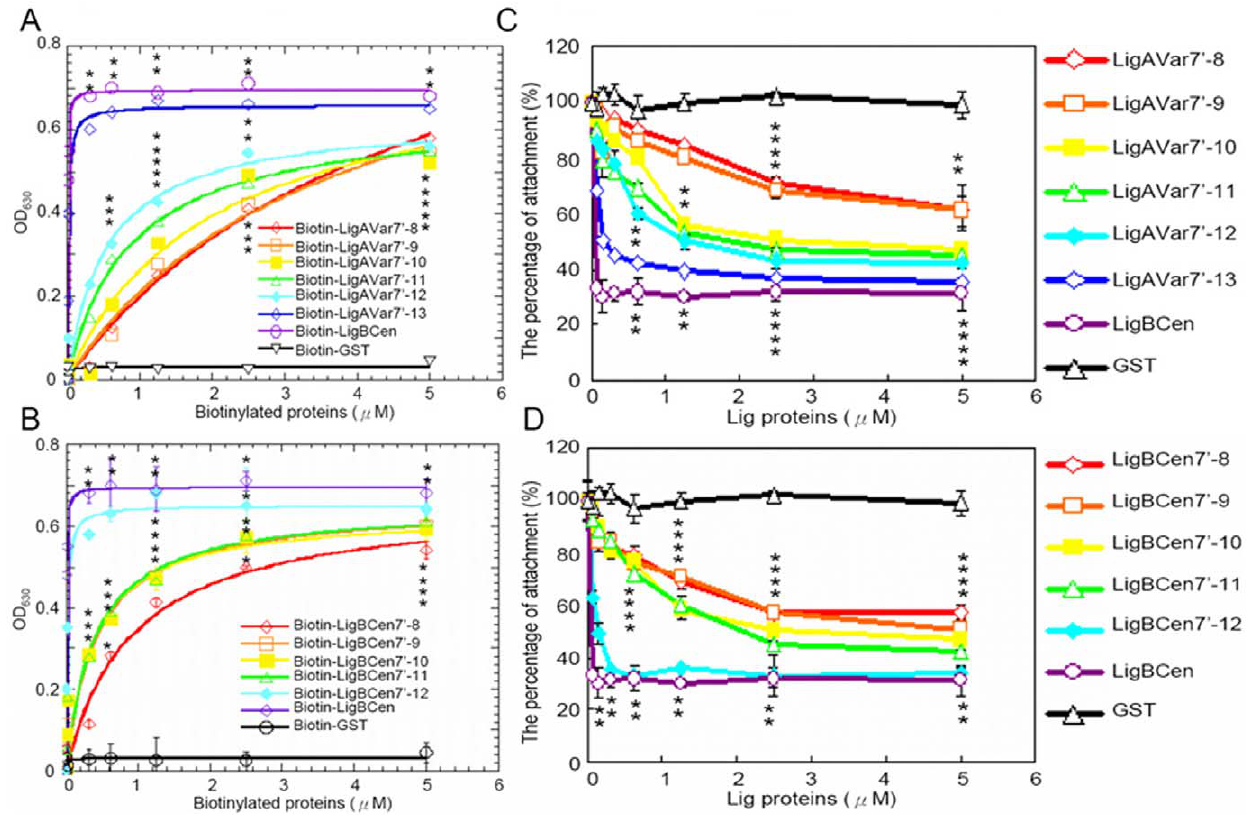
Figure 4. Terminal Ig-like domains mainly mediates Lig protein binding and Leptospiral adhesion on MDCK cells. (A and B) Binding of truncated Lig proteins to MDCK cells. Various concentrations (0.08, 0.16, 0.3125, 0.625, 1.25, 2.5, 5 m M) of biotinylated LigCon (negative control), LigBCen (positive control), and (A) LigAVar7’-13, LigAVar7’-12, LigAVar7’-11, LigAVar7’-10, LigAVar7’-9, LigAVar7’-8, (B) LigBCen7’-12, LigBCen7’-11, LigBCen7’-10, LigBCen7’-9, LigBCen7’-8 were added to MDCK cells (105), and binding was measured by ELISA. (C and D) Truncated Lig proteins inhibit the binding of Leptospira to MDCK cells. MDCK cells were incubated with various concentrations (0.08, 0.16, 0.3125, 0.625, 1.25, 2.5, 5 m M) of biotinylated -LigB1706-1716, or biotin (negative control) (C) LigAVar7’-13, LigAVar7’-12, LigAVar7’-11, LigAVar7’- 10, LigAVar7’-9, LigAVar7’-8, (D) LigBCen7’-12, LigBCen7’-11, LigBCen7’-10, LigBCen7’-9, LigBCen7’-8 prior to the addition of Leptospira (107). The adhesion of Leptospira to MDCK cells (105) was detected by ELISA. The reduced percentage of attachment was determined relative to the attachment of Leptospira on untreated MDCK cells. Each value represents the mean 6 SEM of three trials in triplicate samples. Statistically significant values (P , 0.05) are indicted by *.